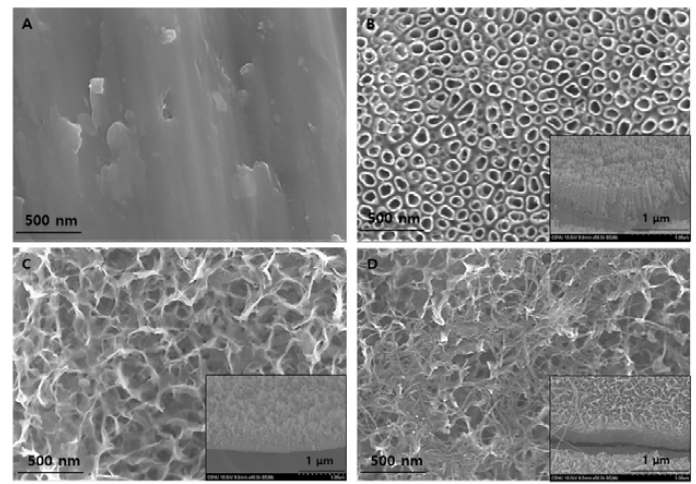
Figure 1. Field emission scanning electron microscope (FE-SEM) images of surfaces of different specimens: ( A ) Pure titanium (PT); ( B ) TiO 2 nanotubes (PTN); ( C ) TiO 2 nanotubes + alkali treatment (PTNA); and ( D ) TiO 2 nanotubes + alkali treatment + multiwall carbon nanotubes coating (PTNAC).